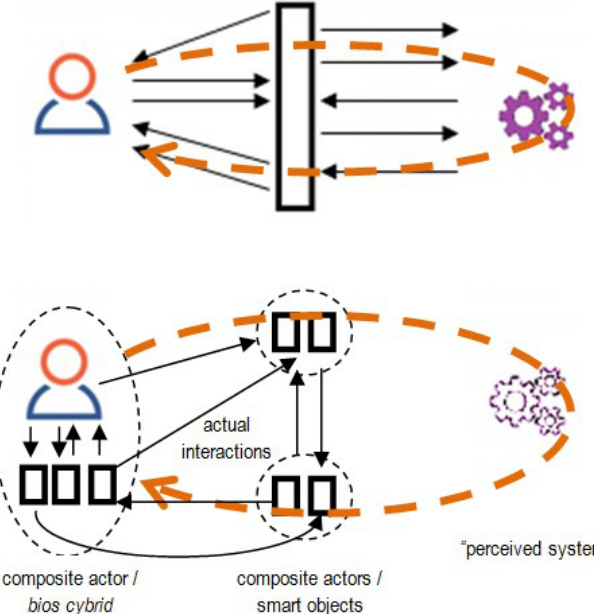
Fig. 25. Above: a traditional concept for user interface. Below: rethinking the user interface as a disperse set of devices which lead, direct or indirectly, to a perceived connection to a single responsive entity – the